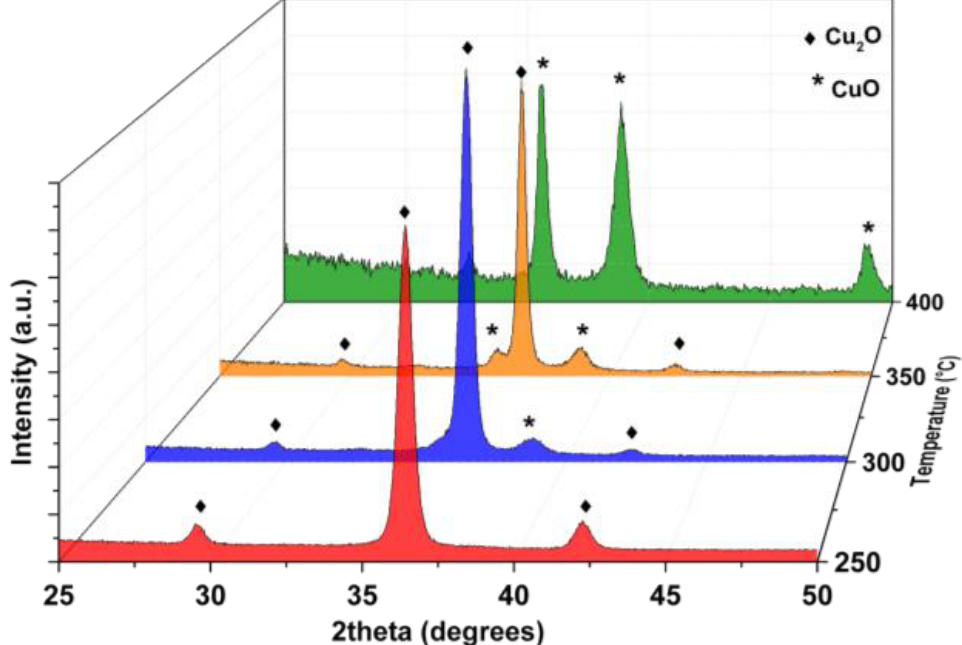
Figure 1. X-ray diffraction patterns of the Cu 2 O and CuO thin films prepared by MOCVD on the Si substrate at different temperatures from 250 °C (red line), 300 °C (blue line), 350 °C (orange line) to 400 °C (green line).